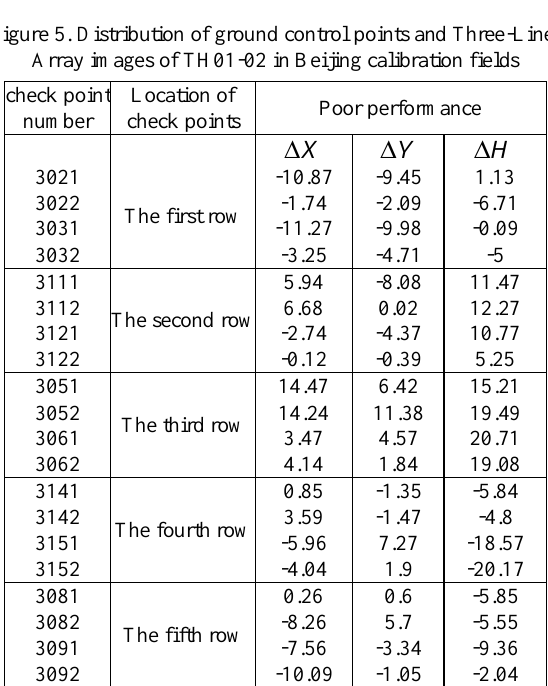
Table 7. Positioning accuracy without ground control points